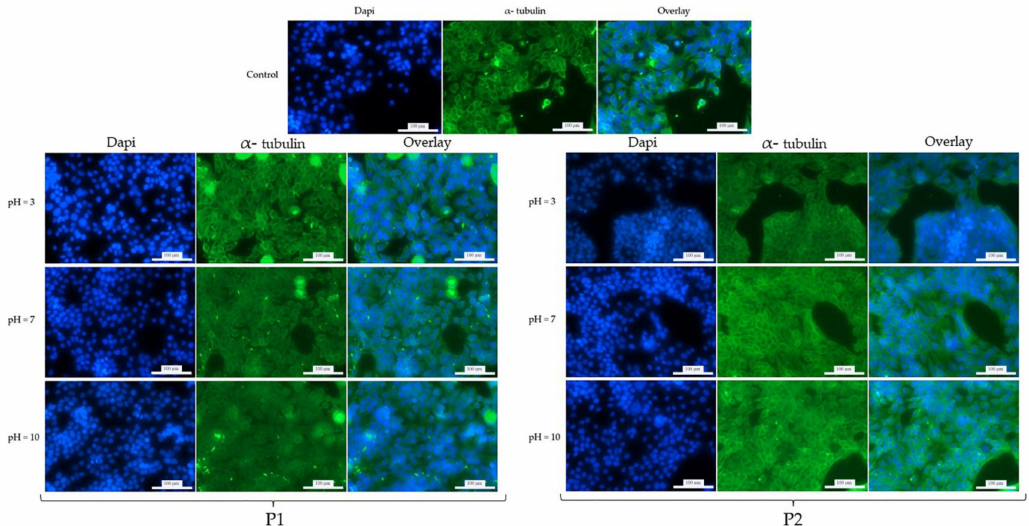
Figure 7. Detroit cells visualized by fluorescence microscopy after 72 h of treatment with P1 and P2 (75 µ g/mL) in artificial saliva with three types of pH (acid, neutral, and basic). Nuclear and microtubule staining are expressed both separately (DAPI and α -tubulin, respectively) and combined (overlay). Both the structure of the nuclei and the distribution of the cytoskeleton were uniform in the cells treated with P1 and P2 and in the control cells